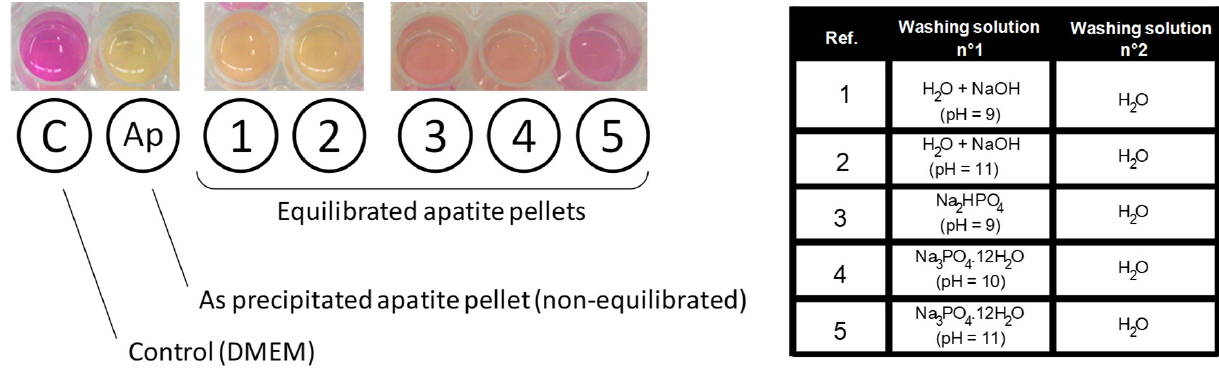
Figure 5. Coloration of phenol red indicator for various conditions. “C” denotes the control (DMEM alone), “Ap” denotes the freeze-dried apatite pellet (hap-1d, without equilibration), and refs. 1 to 5 denote experiments that included a modified washing step, with equilibration in different alkaline conditions. All experiments were performed at 37 °C for 24 h under atmospheric air, in 24-well culture plates (each well has an internal diameter of 15.6 mm).